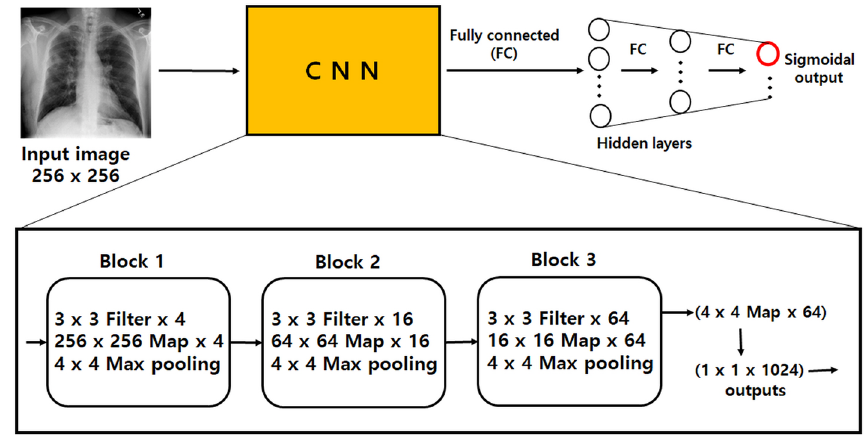
Figure 2. A detailed schematic representation of the actual architecture of